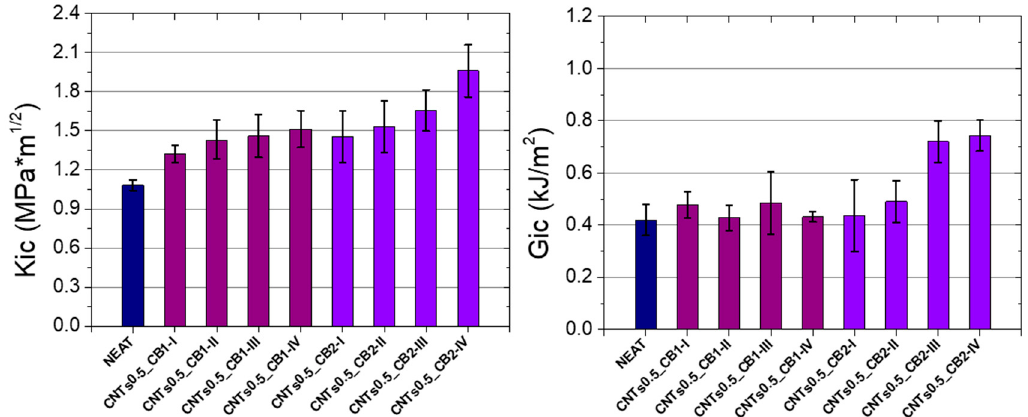
Figure 5. K ic and G ic mean values for ternary specimens.